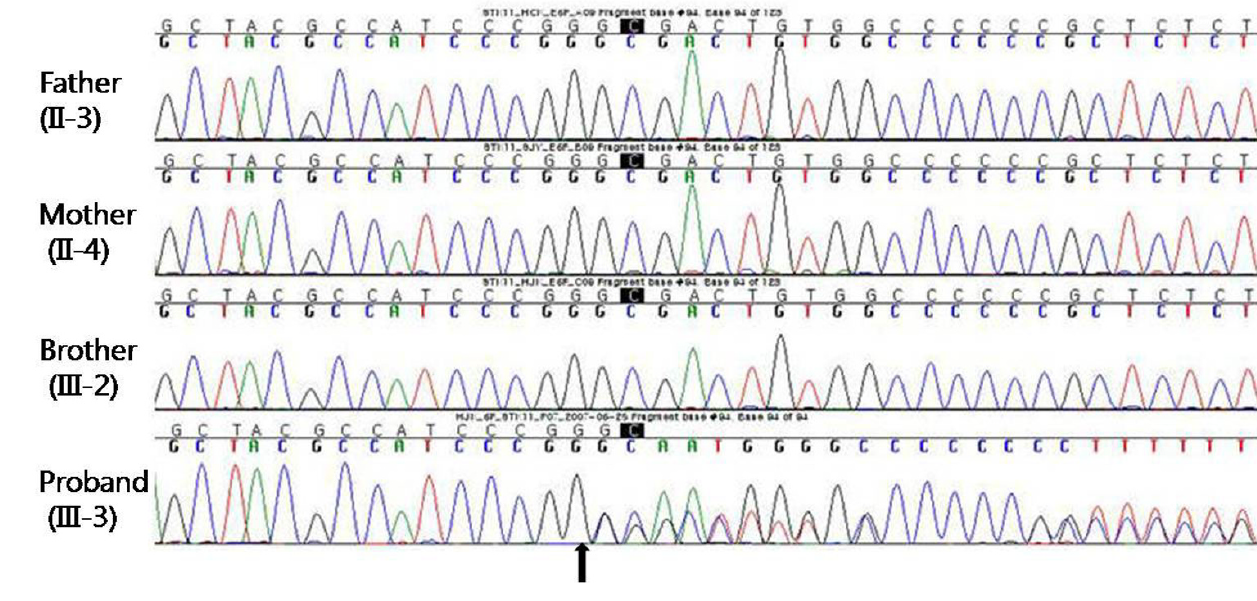
Figure 3 Identification of the STK11 gene mutation . Direct sequencing of the proband demonstrated a 1-bp deletion (c.826delG) in exon 6 of the STK11 gene, resulting in a frameshift deletion mutation (p.Gly276AlafsX11). The proband's family members did not have the mutation. The localization of the deletion is indicated by the